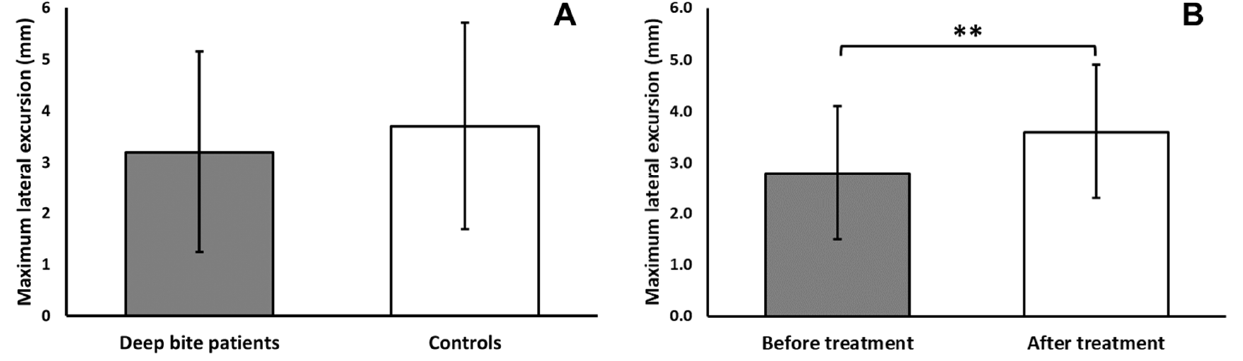
Figure 3. ( A ) Maximum lateral excursion in deep bite patients compared to controls, showing a tendency towards a smaller lateral component in the malocclusion group. ( B ) Maximum lateral excursion in deep bite patients, before and after treatment with FGB, showing a significant increase in the lateral component of the chewing pattern. ** p < 0.01.